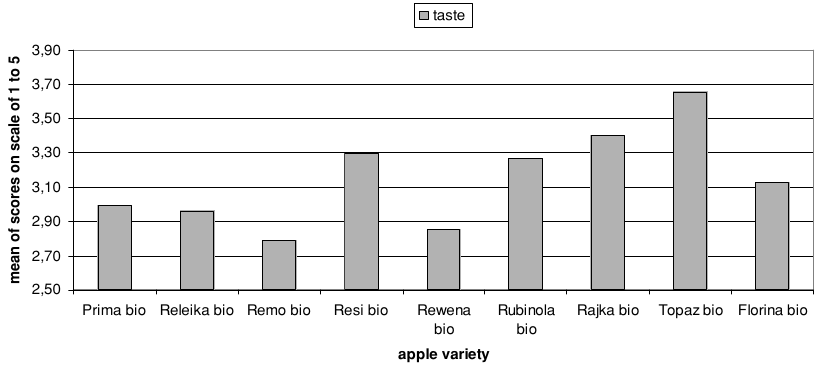
Figure 3: Mean scores given to taste for the nine varieties examined